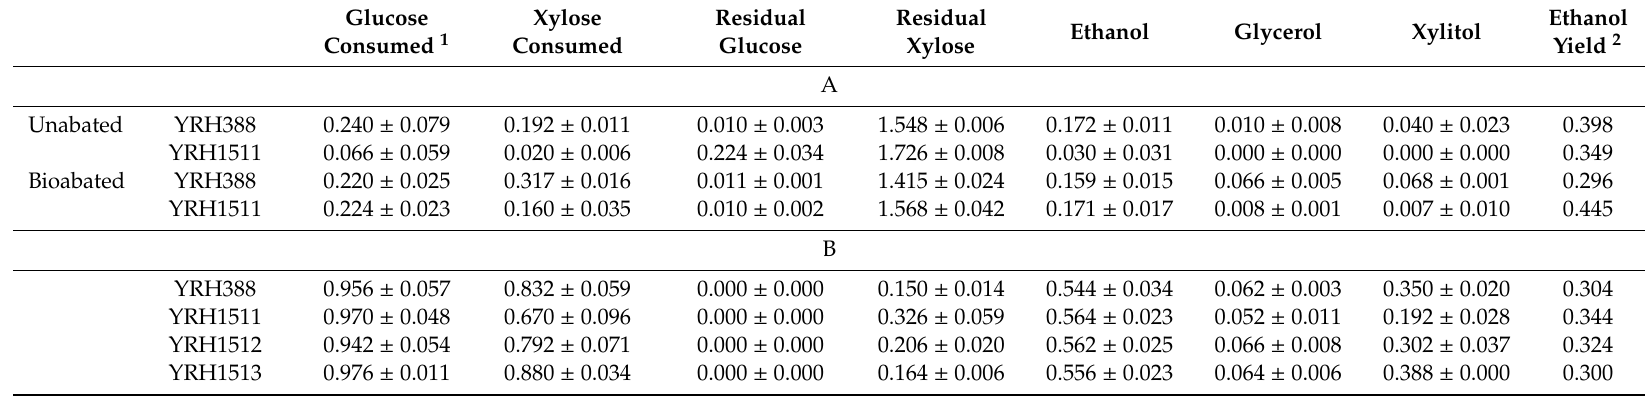
Table 4. A: Fermentation of corn stover hydrolysate by S. cerevisiae YRH388 and YRH1511; B: Fermentation of rich medium containing glucose and xylose.